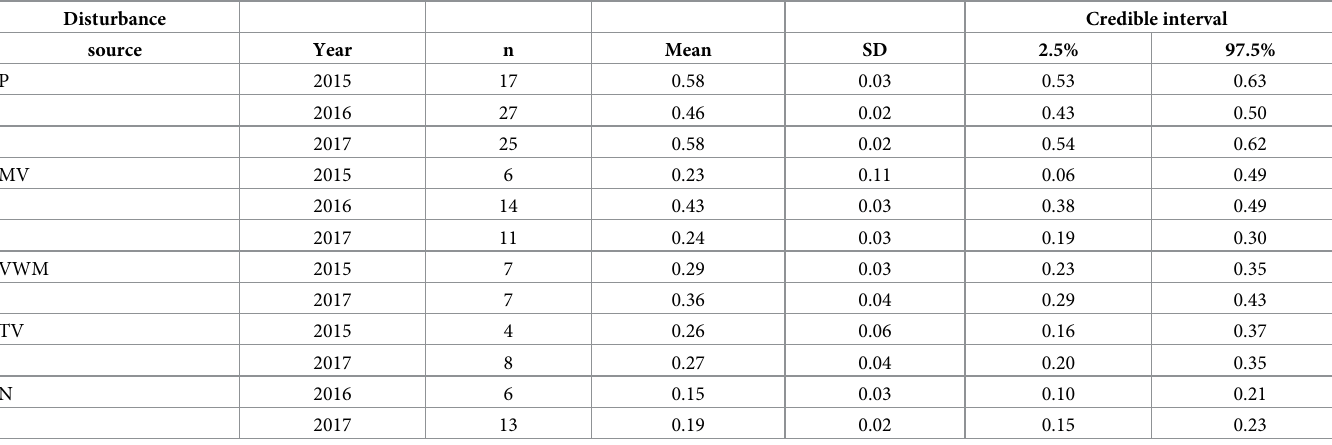
Table 1. Posterior summaries for the proportion of seals presenting a high intensity reaction, i . e . flushing, to a disturbance source. Disturbance Credible interval